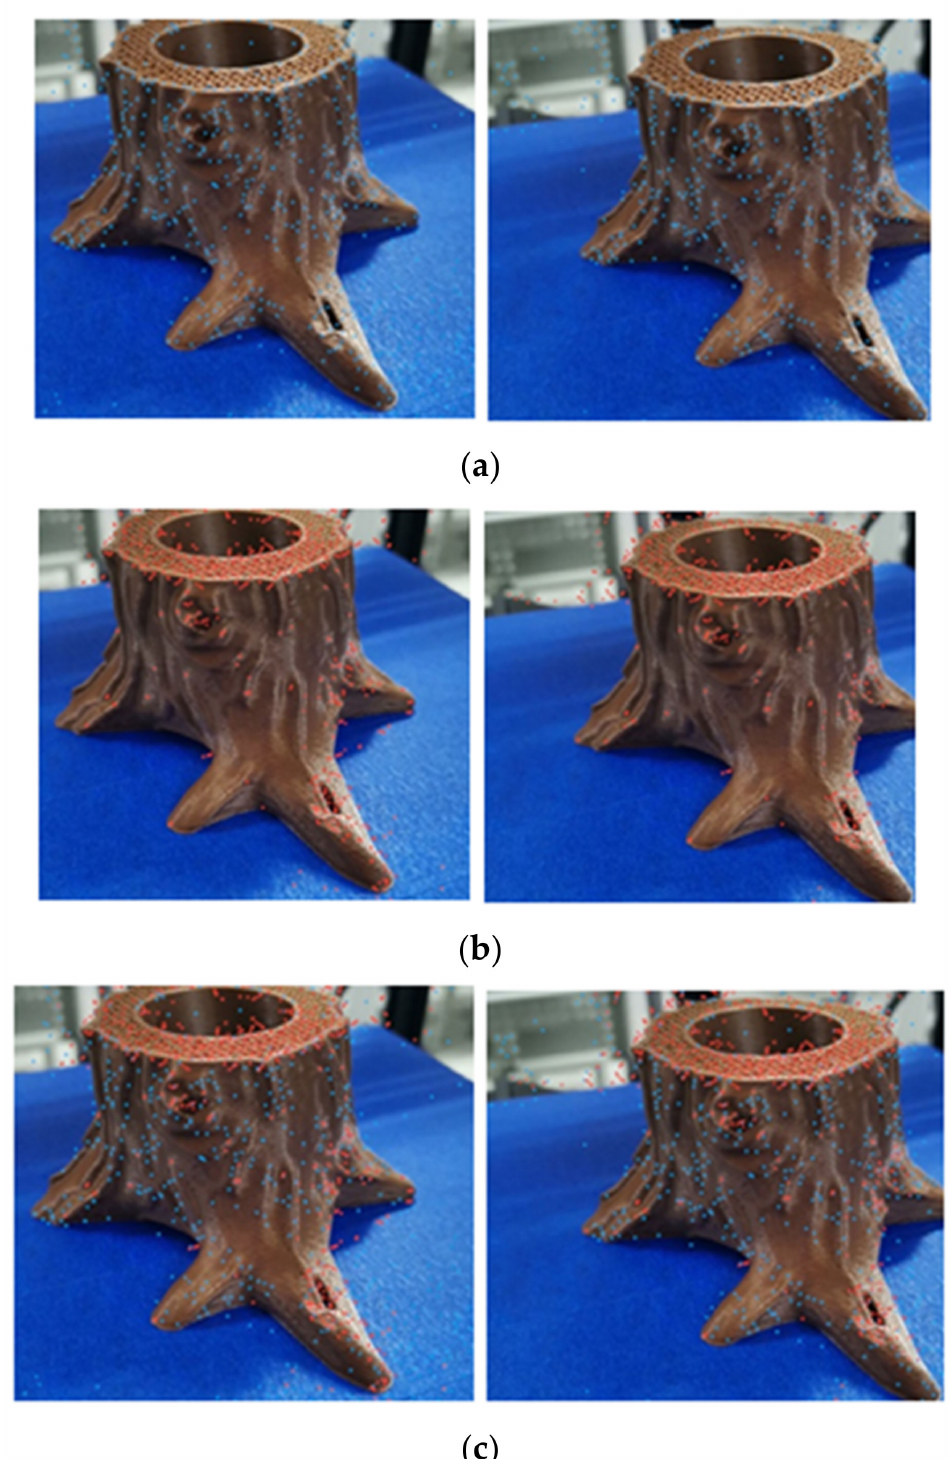
Figure 8. Three algorithms are used to extract the renderings of the feature points ( a ) Feature point extraction effect based on FFT-SIFT; ( b ) Feature point extraction effect based on the AKAZE; ( c ) Feature point extraction effect based on the FFT-SIFT-AKAZE